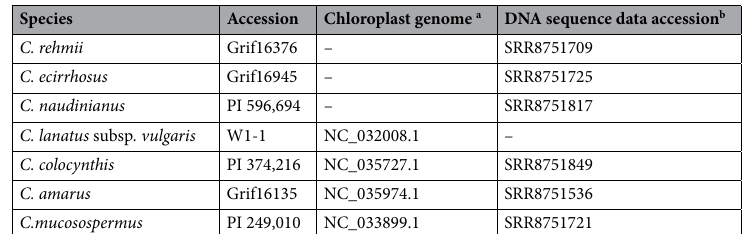
Table 5. A list of the seven Citrullus species used in the study. a Plant chloroplast genome directly download from the NCBI ORG database. b Plant whole genome re-sequence data downloaded from the NCBI SRA database according to the accession in Guo et al. 1